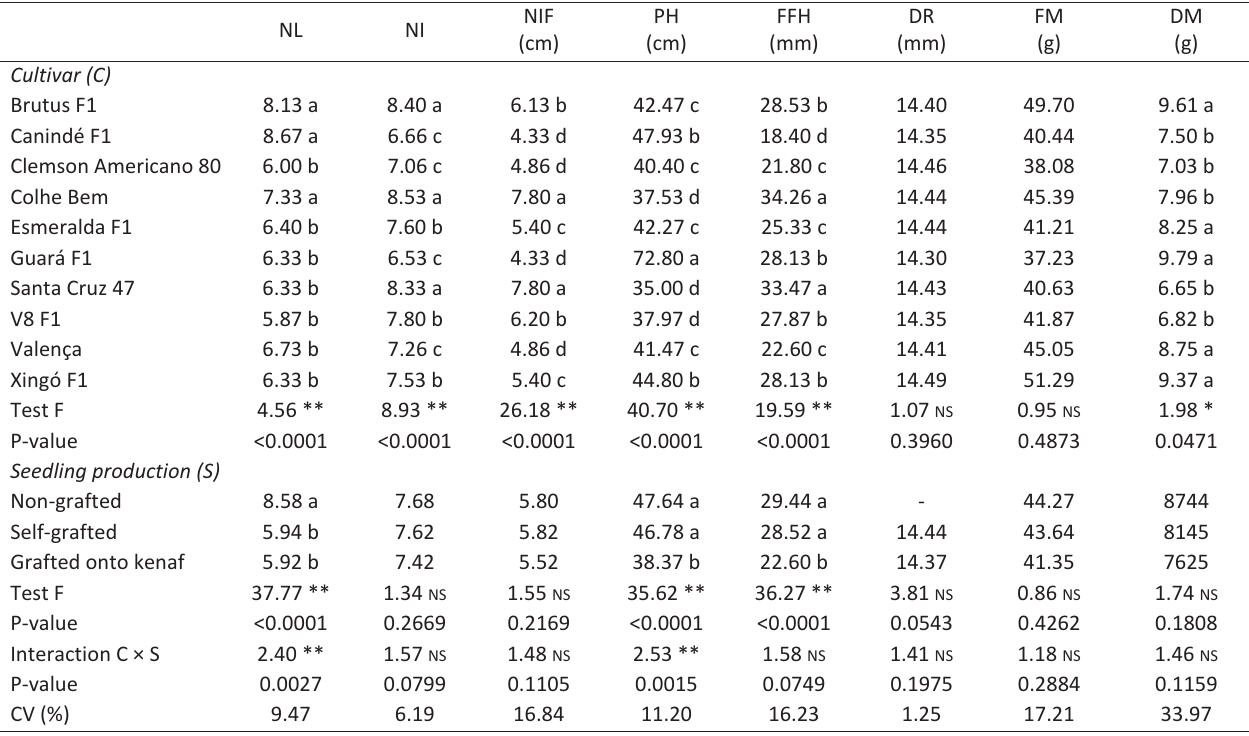
Table 2 ­ Analysis of variance and test of comparison of means of vegetative variables of okra cultivars and seedling production